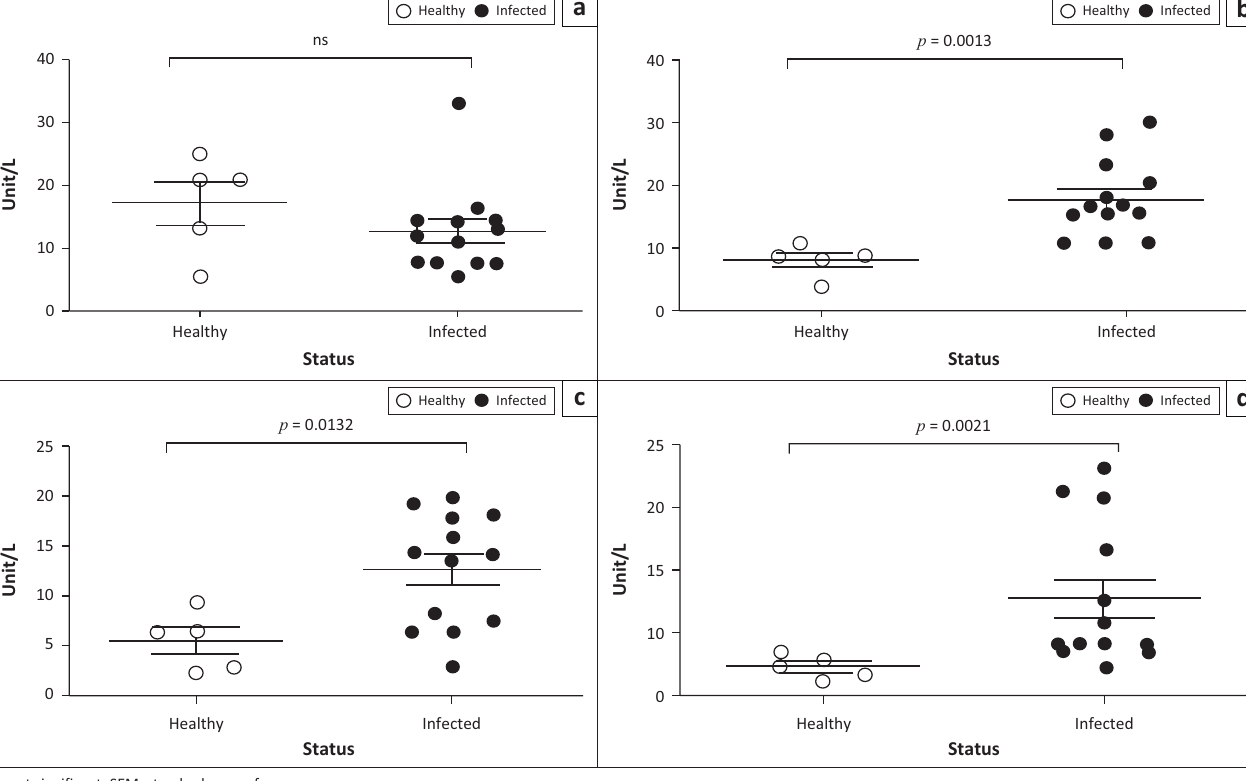
FIGURE 5: Natural peste des petits ruminants virus–infected Black Bengal goats showed elevated serum enzymes. Serum samples were collected from healthy and peste des petits ruminants –affected goats and the amount of (a) alkaline phosphatase, (b) creatine kinase, (c) aspartate transaminase and (d) alanine transaminase was measured. Data indicate mean ± SEM from 5 healthy and 13 peste des petits ruminants virus–infected goats. One-tailed Mann–Whitney test. p ≤ 0.05 was considered statistically